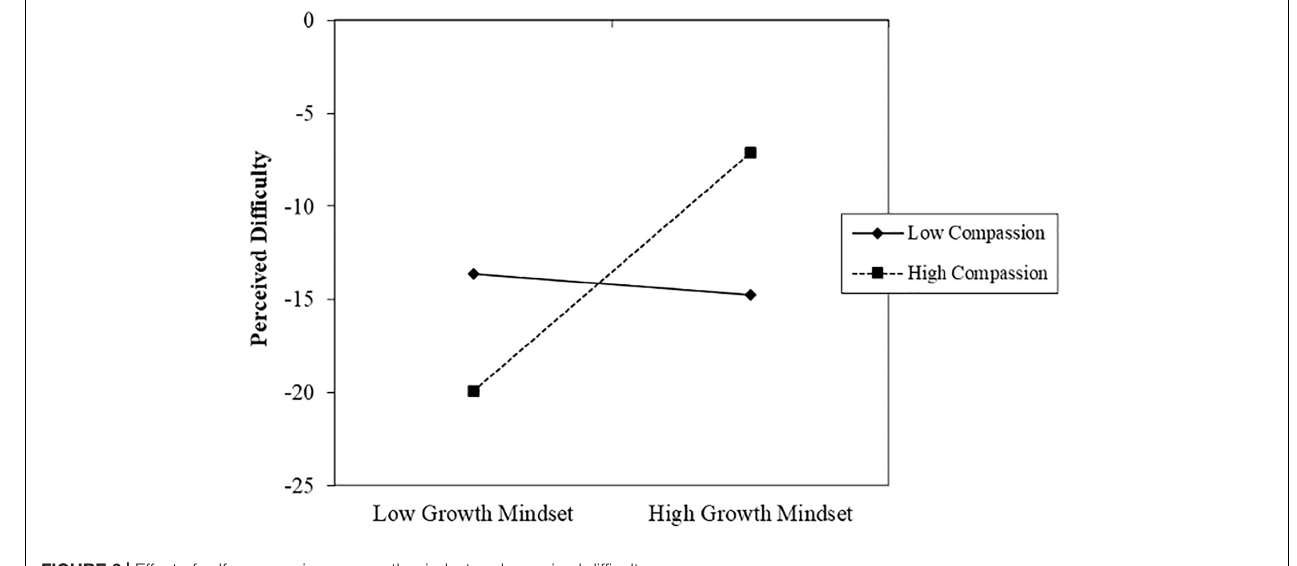
FIGURE 6 | Effect of self-compassion on growth mindset and perceived difficulty.